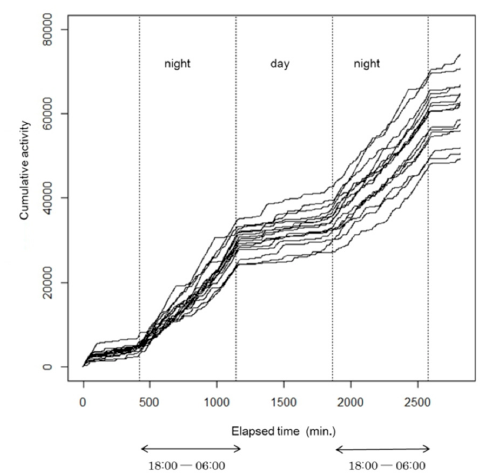
Figure 1. Cumulative number of movements of each of the 16 rats over a 36-h period.